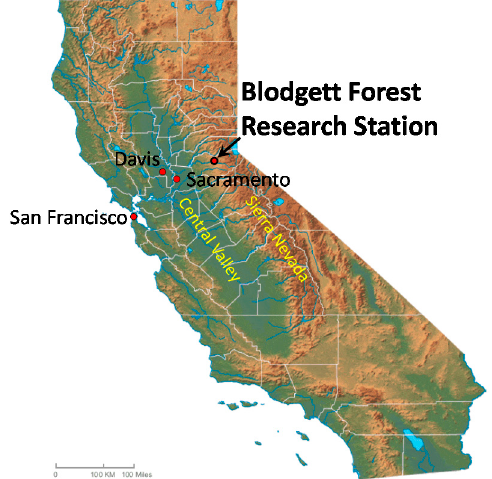
Figure 3. Location of the study site.